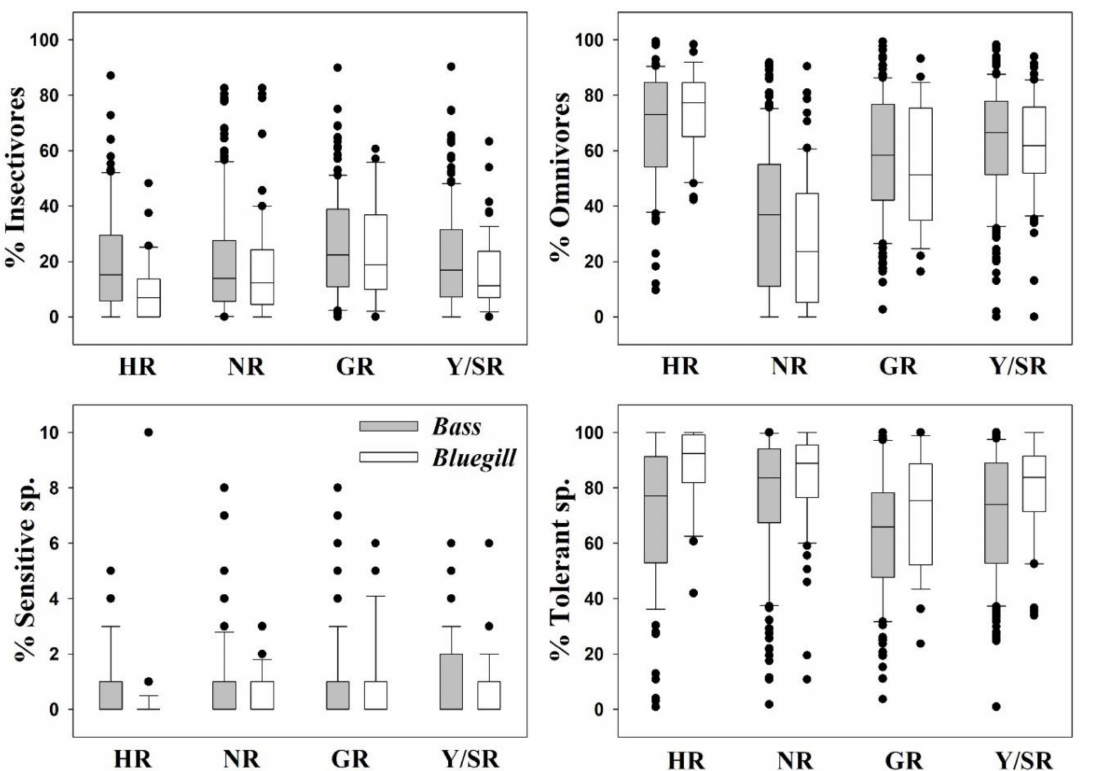
Figure 5. Relative abundance of M. salmoides and L. macrochirus against stream order and ecological health assessment based on the Index of Biological Integrity (IBI). HR = Han River, NR = Nakdong River, GR = Geum River, Y/SR = Yeongsan/ Seomjin